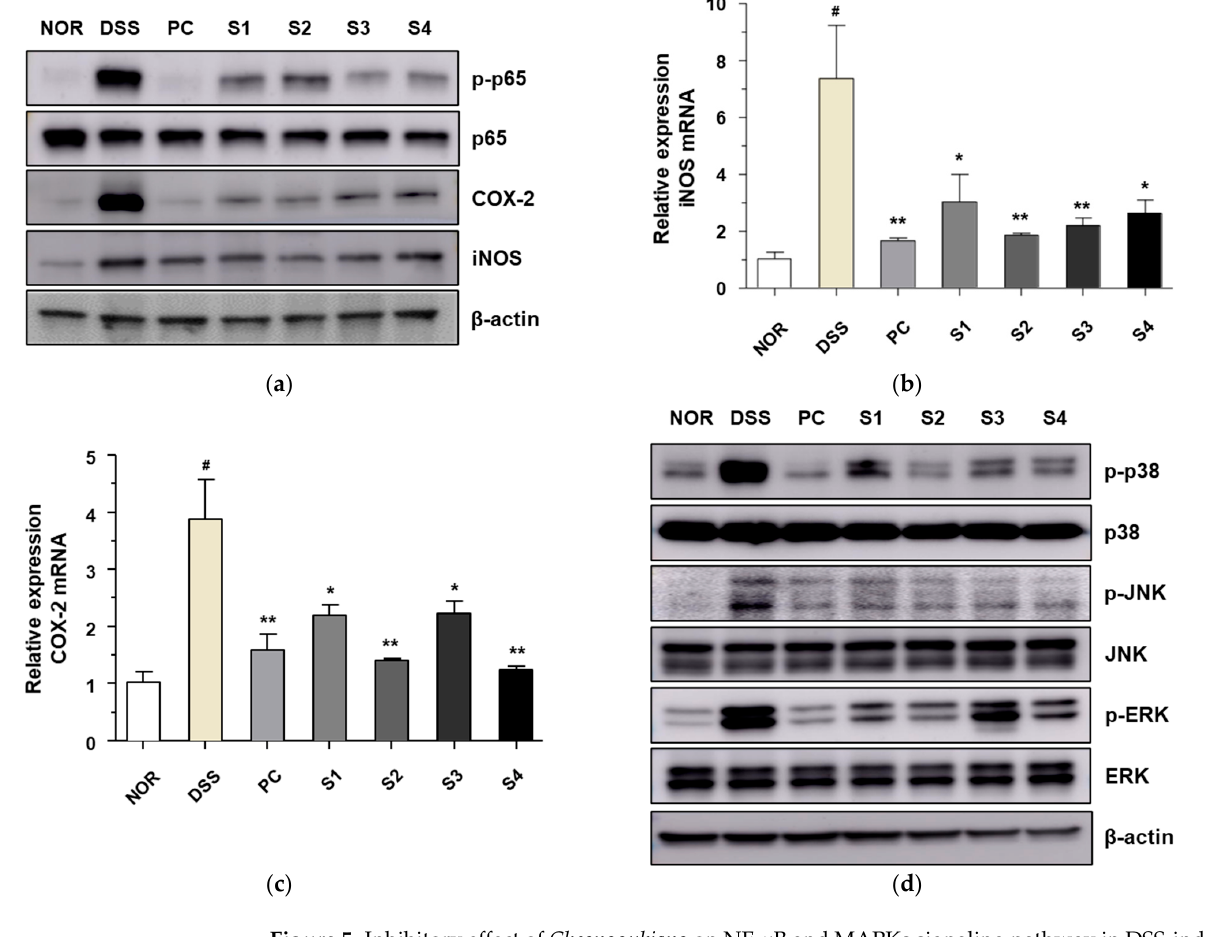
Figure 5. Inhibitory effect of Cheonggukjang on NF- κ B and MAPKs signaling pathway in DSS-induced colitis mice: ( a ) The protein levels of phosphorylated p65, p65, COX-2, and iNOS were determined via western blot assay; mRNA levels of ( b ) iNOS and ( c ) COX-2 were analyzed by quantitative real-time PCR; ( d ) The protein levels of total and phosphorylated p38, JNK, and ERK were determined via western blot assay. Values are presented as the mean ± SD (n = 5); #, p < 0.005 versus normal group; **, p < 0.005; *, p < 0.05 versus DSS group.